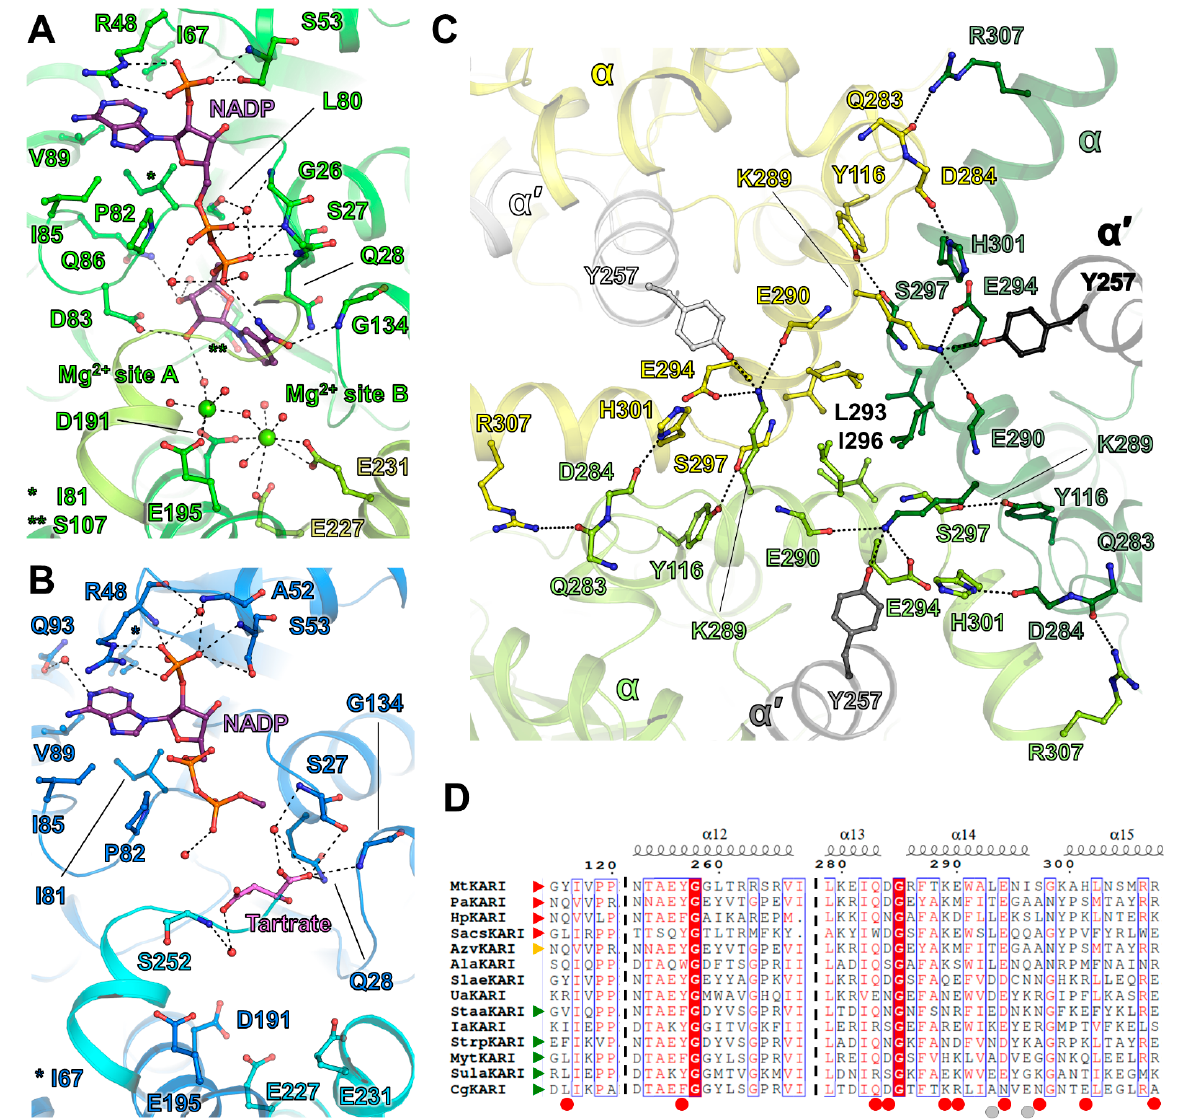
Figure 2. Ligand coordination and dodecamer stabilisation. The close ( A ) and open ( B ) state structures are represented in cartoon and are coloured in green and blue, respectively. The dimer chain is in a lighter colour. Ligands are represented as balls and sticks and are coloured in red, blue, orange and light green for oxygen, nitrogen, phosphorus and Mg 2+ , respectively. NADP is coloured in purple, tartrate in pink. ( C ) An inside view of the close up of the trimeric interface. The structures are represented in cartoon and are coloured per monomer. Residues stabilising the interface are represented by sticks and are coloured, as in ( A ) and ( B ). ( A – C ) Hydrogen bonds are shown by black dashed lines. ( D ) ESPript alignment of the residues 115–120, 253–267 and 279–307 ( Mt KARI numbering) in the structurally characterised KARIs. Red and green arrows indicate experimentally proven dodecameric and dimeric enzymes, respectively. The orange arrow points to Azv KARI, which is supposed to be dodecameric, even if initially described as a dimer [12,17]. Red circles indicate residues involved in polar contacts at the trimeric interface. Grey circles indicate residues involved in the hydrophobic interaction.